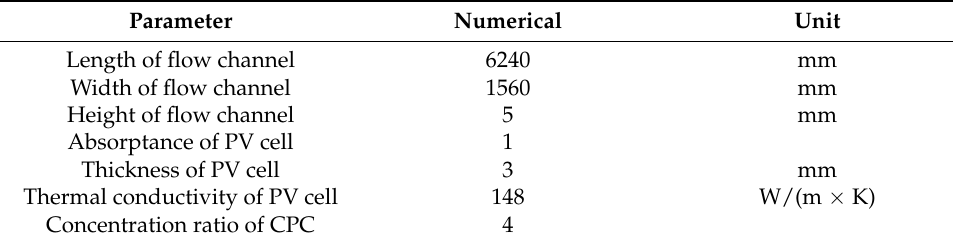
Table 3. Dimension parameter of LCPV/T [28]. Parameter Numerical